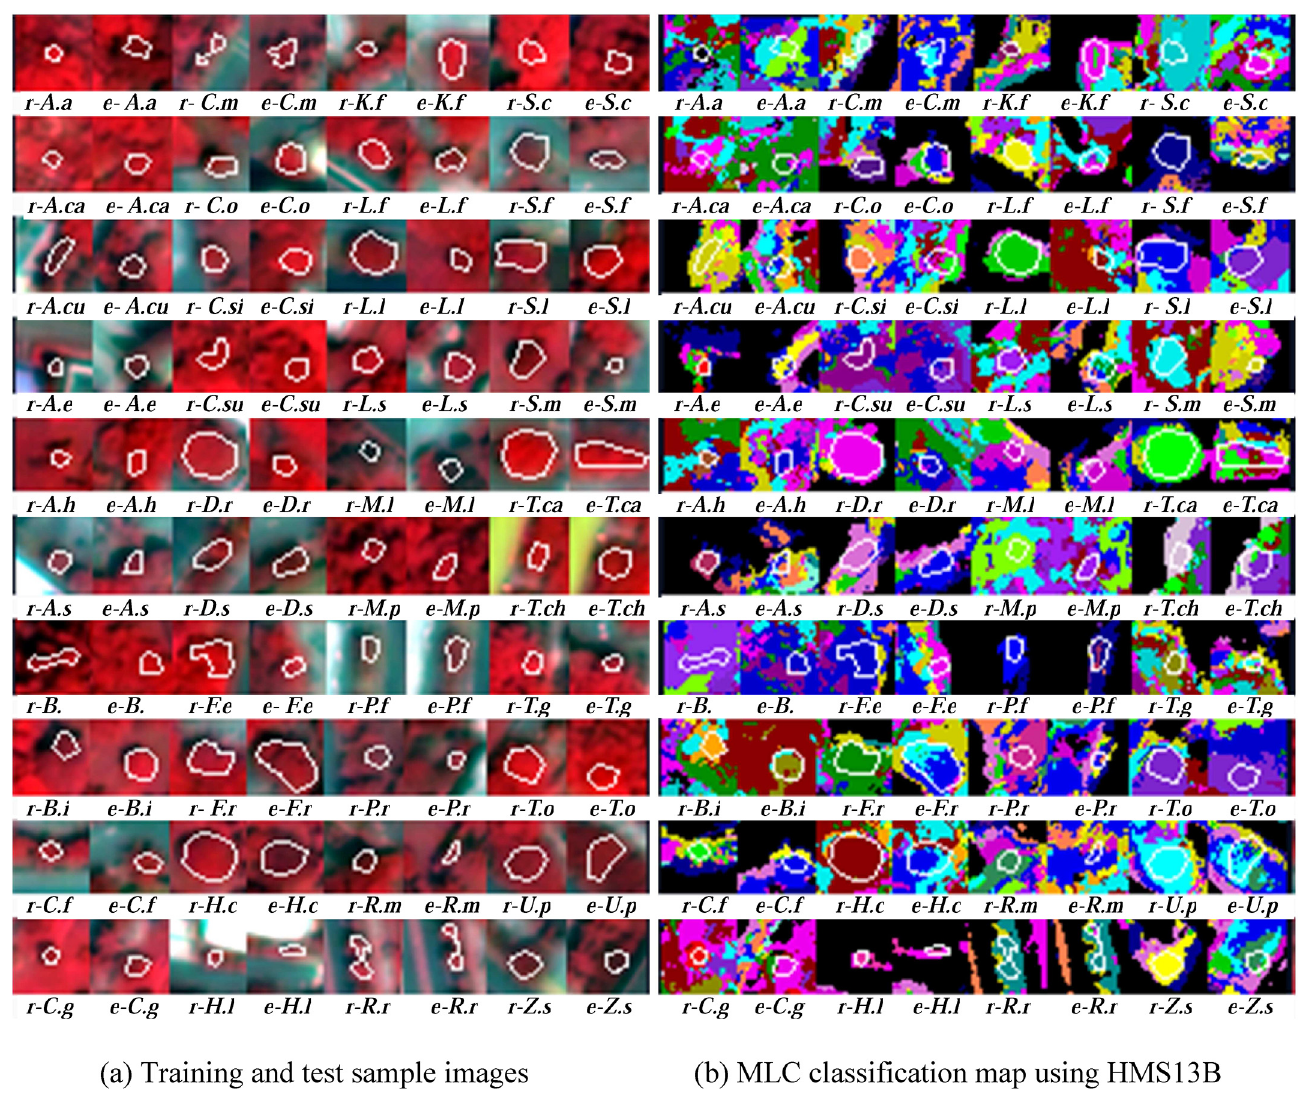
Fig 6. A magnified view of the images (a) and classifications result of tree species (b). Below each image, the prefixes “ r- ” and “ e- ” before the code of tree species denote training and test samples respectively. The white polygon in an image depicts the training samples or test samples of that specific